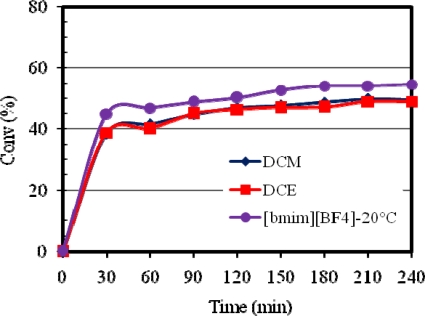
Activity of 1 in [bmim][BF4], DCM and DCE at 20 °C.